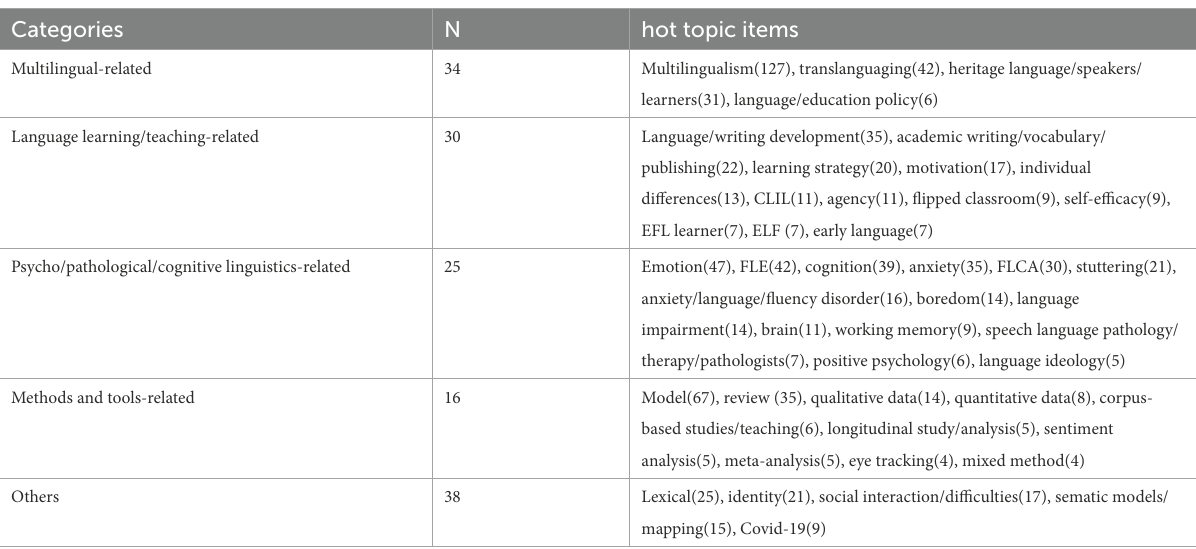
TABLE 6 Categorization of the most explored research